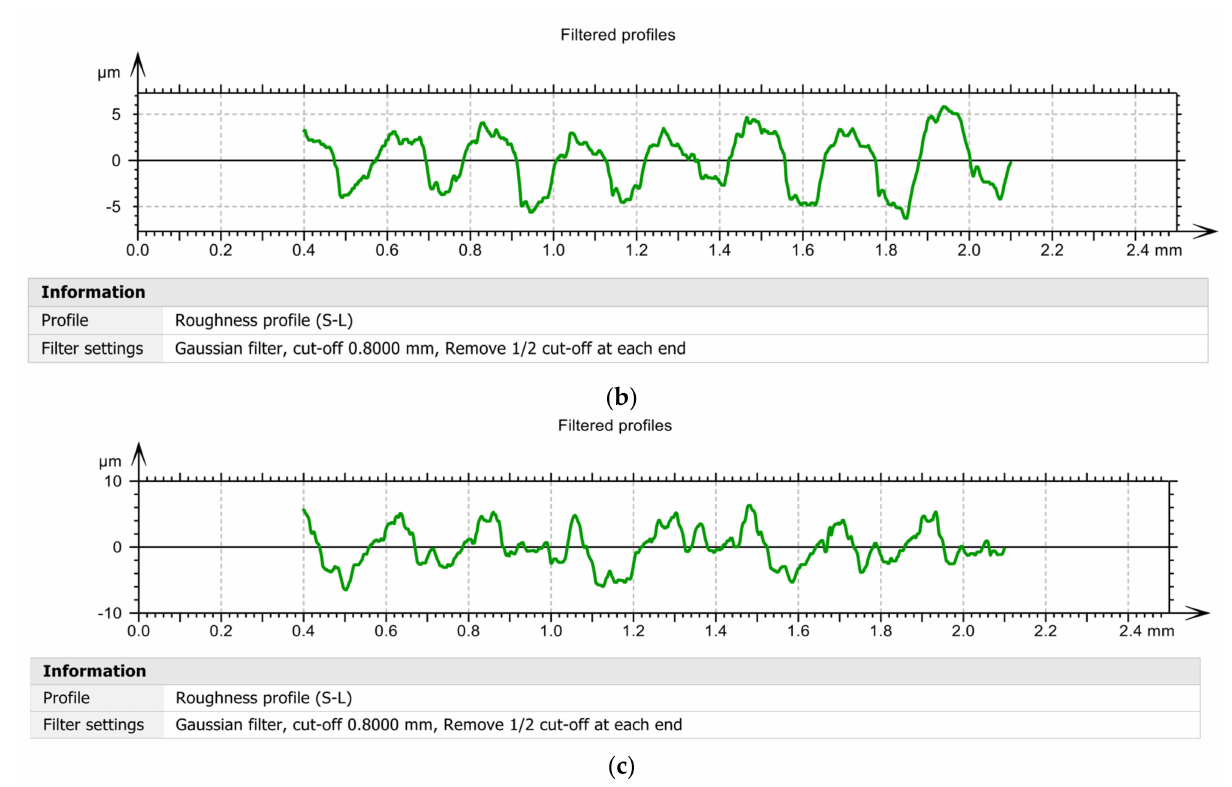
Figure 13. Filtered profiles: ( a ) in the case of machining with a T01 cutting tool; ( b ) in case of machining with T02 cutting tool; ( c ) in case of machining with cutting tool